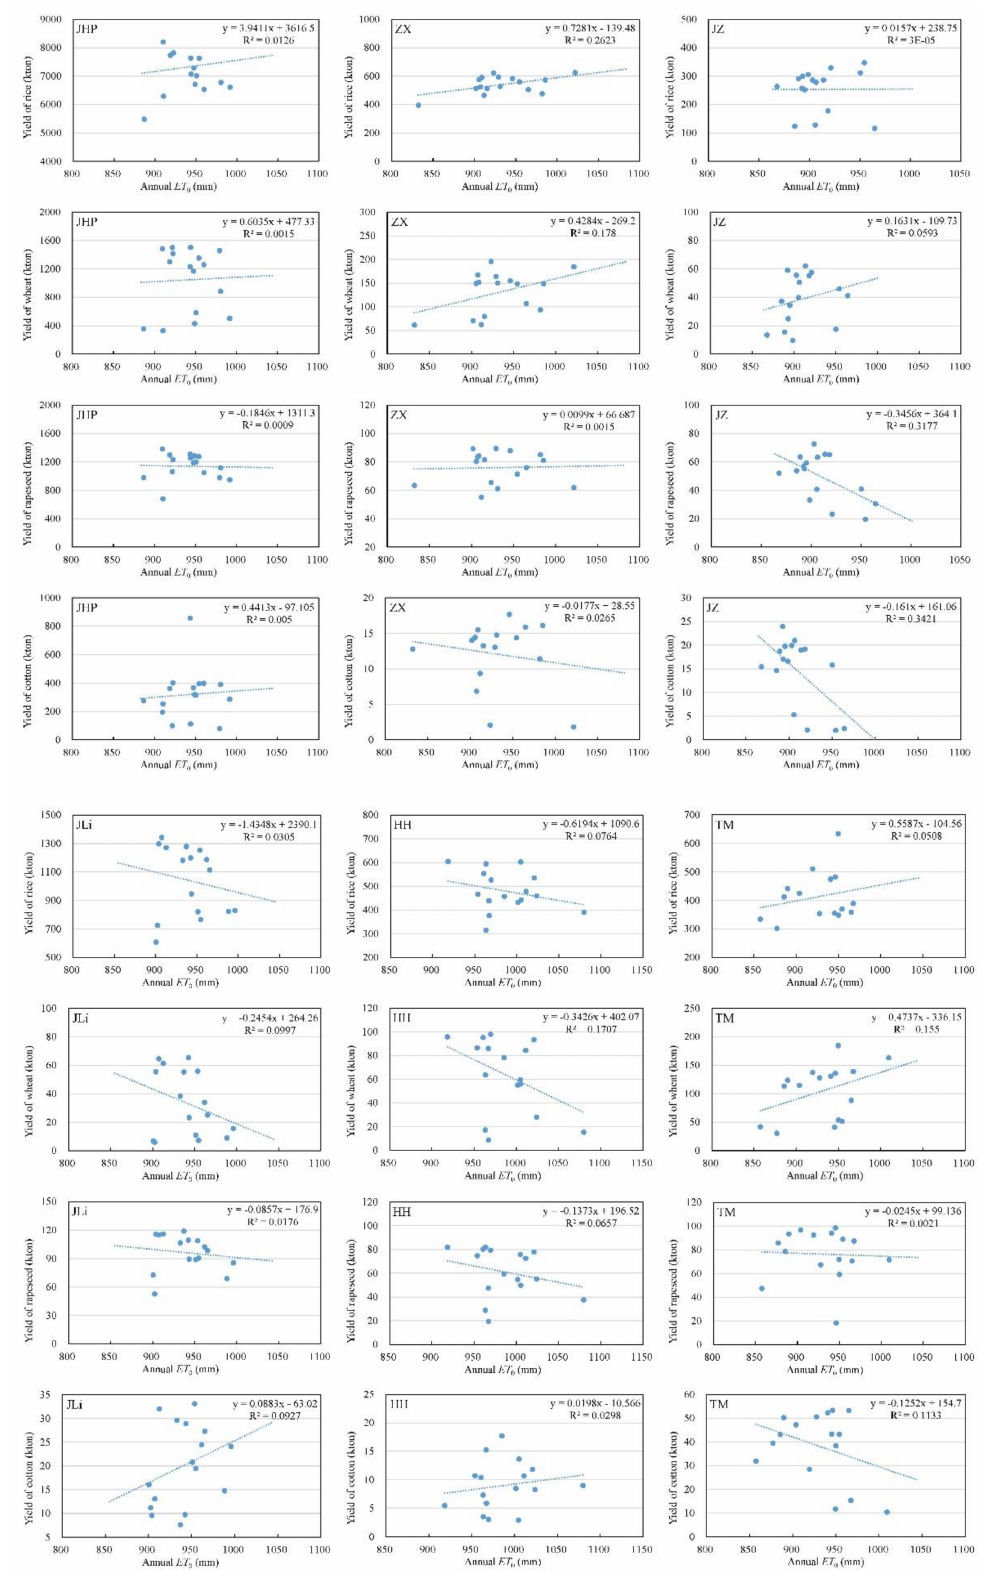
Figure 9. Correlations between annual ET 0 and yields of main crops in JHP and its